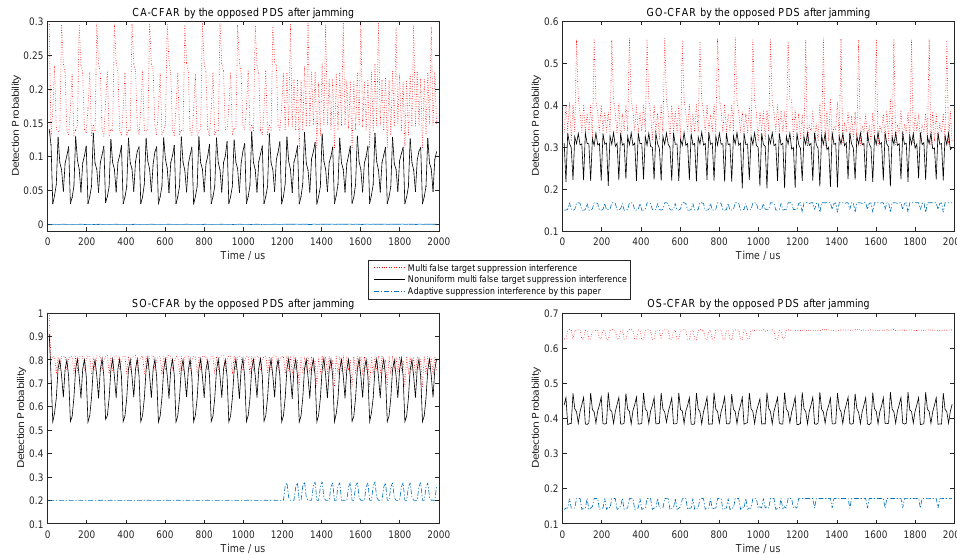
Figure 7. Comparing to [31,32], detection probability of CA, GO, SO, and OS-CFAR before and after jamming when the number of reference units is 6.